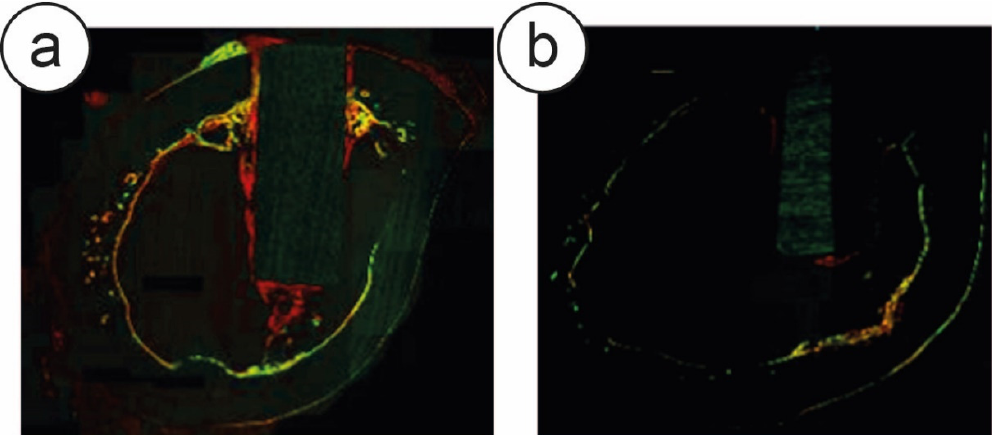
Figure 2. Confocal microscopy of intravitally stained small rods (2 × 5 mm) inserted in the femurs of rabbits. Stains indicate bone formation at 1 week (green), 2 weeks (red), 5 weeks (yellow). Significant bone was observed to have accumulated at the implant-bone interface, shown as red staining, at the 2-week time period near the TiC-coated implants and especially in the cancellous zone of the bone. Indeed, a significant quantity of new bone had already formed at 1 week near the TiC-coated implants [panel ( a )]. Conversely, only a small amount of bone had formed around the uncoated Ti implants at 2 weeks [panel ( b )] and no bone formation was visible at 1 week. Reprinted from [22]. Copyright (2007), with permission from Elsevier